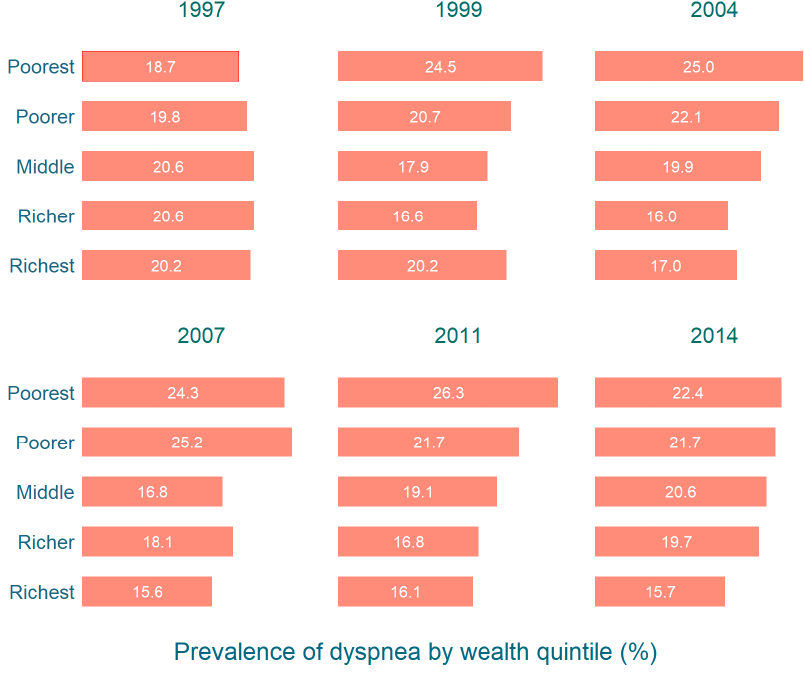
Figure 4. Prevalence of dyspnoea among under-five children by household wealth quintile in Bangladesh 1997–2014.